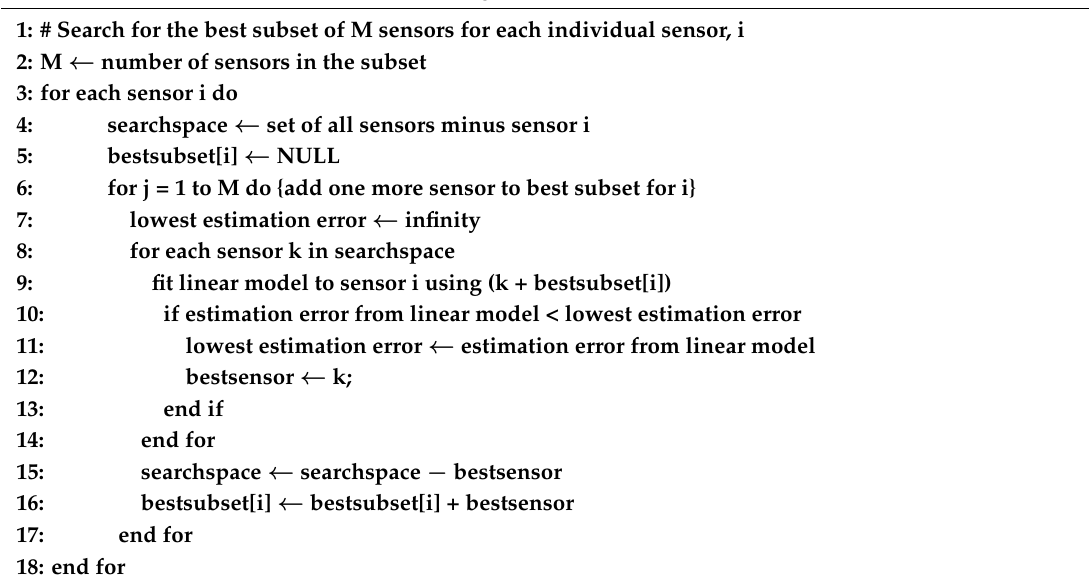
Algorithm 2: Best subset selection of M co-integrated nodes from N − 1 candidates for each of N nodes 1: # Search for the best subset of M sensors for each individual sensor,